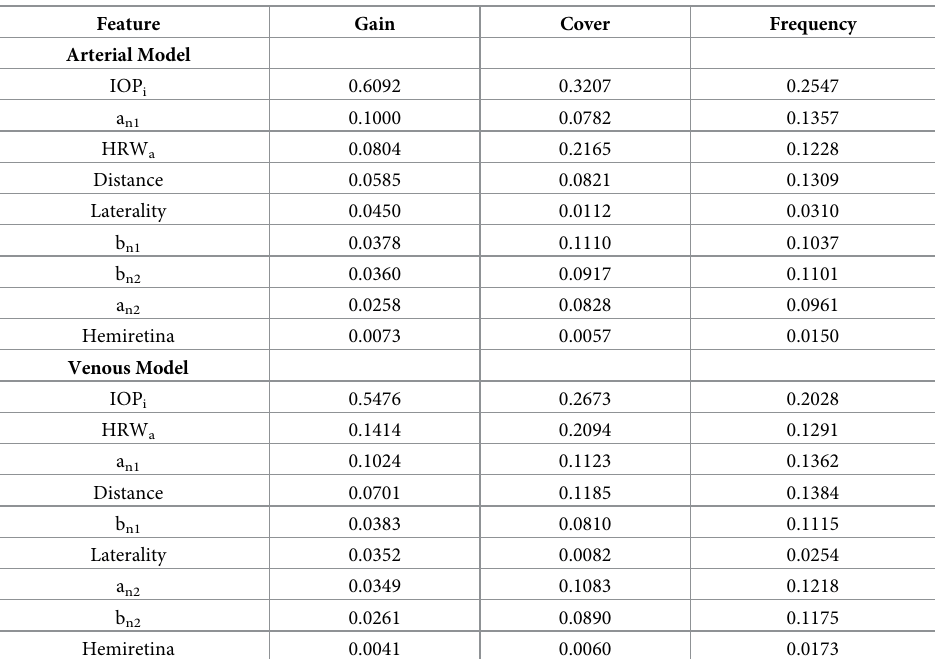
Table 3. Feature importance of the machine learning